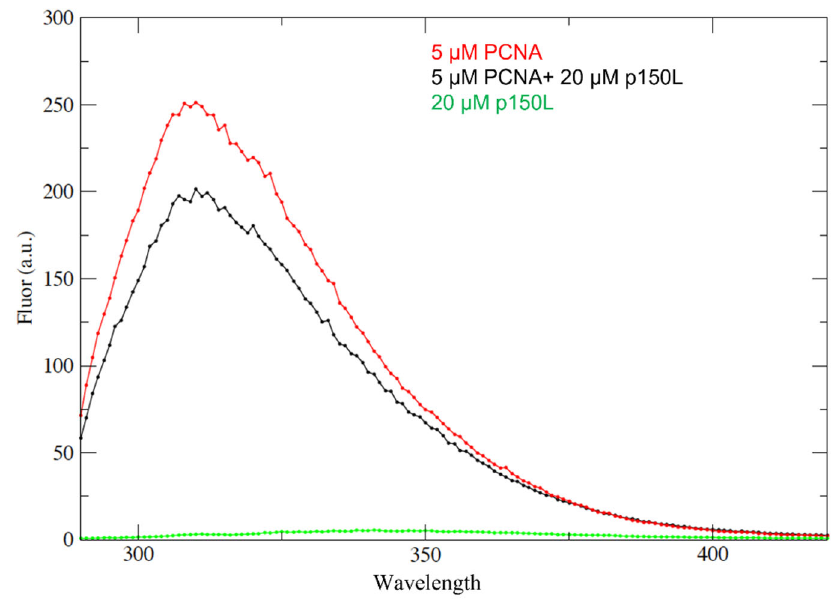
Figure 9. p150L binding to PCNA studied by fluorescence quenching. Samples were excited at 280 nm and the emission spectra recorded between 295 nm and 420 nm were collected. The red curve shows the emission spectrum for 5 μ M PCNA monomer on its own. The black curve shows the spectrum for a complex containing 5 μ M PCNA monomer and 20 μ M p150L. The green curve shows the spectrum for 20 μ M p150L on its own. Due to the absence of tryptophan, the emission spectrum for p150L is near the baseline.